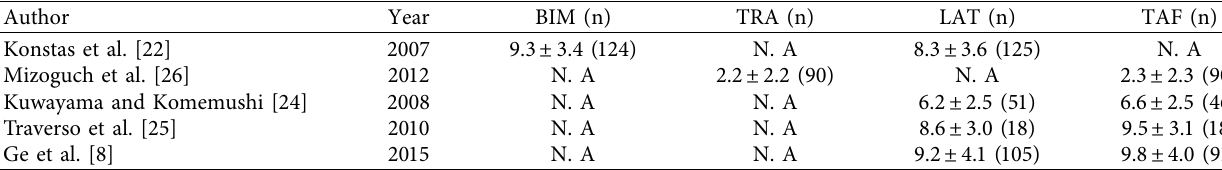
Table 4: Reduction of IOP from baseline of PGAs in OAG/OHT.